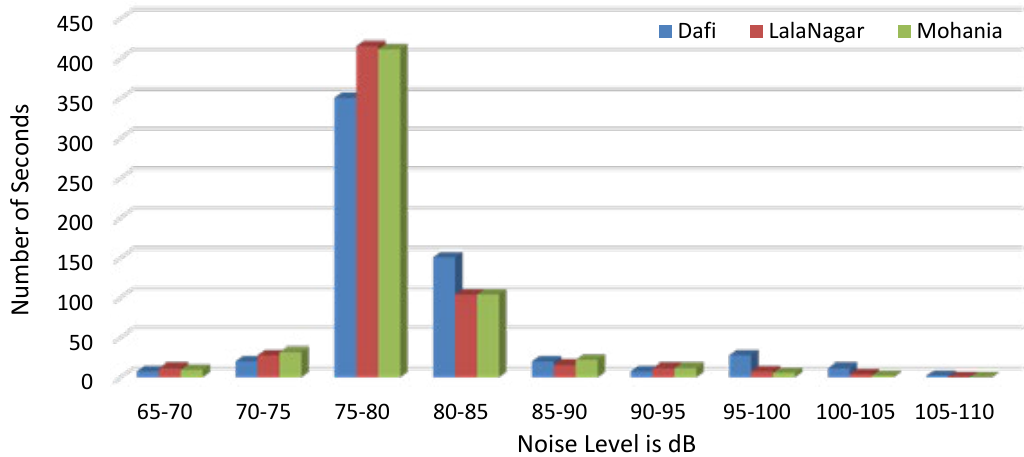
Fig. 3: Number of seconds of noise levels in dB in 10 min interval using Extech SL10